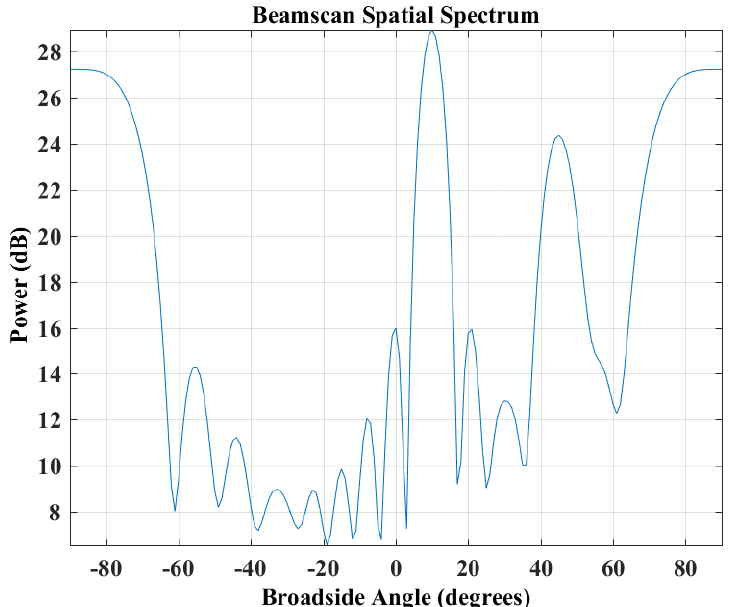
Figure 6. The spatial spectrum of the three components of the UG MIMO receive